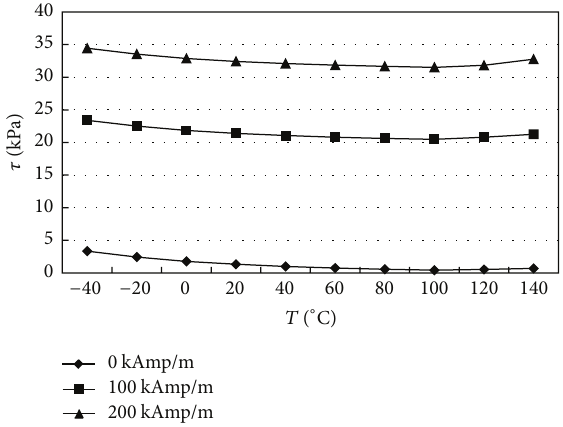
Figure 2: The curve of the shear stress versus